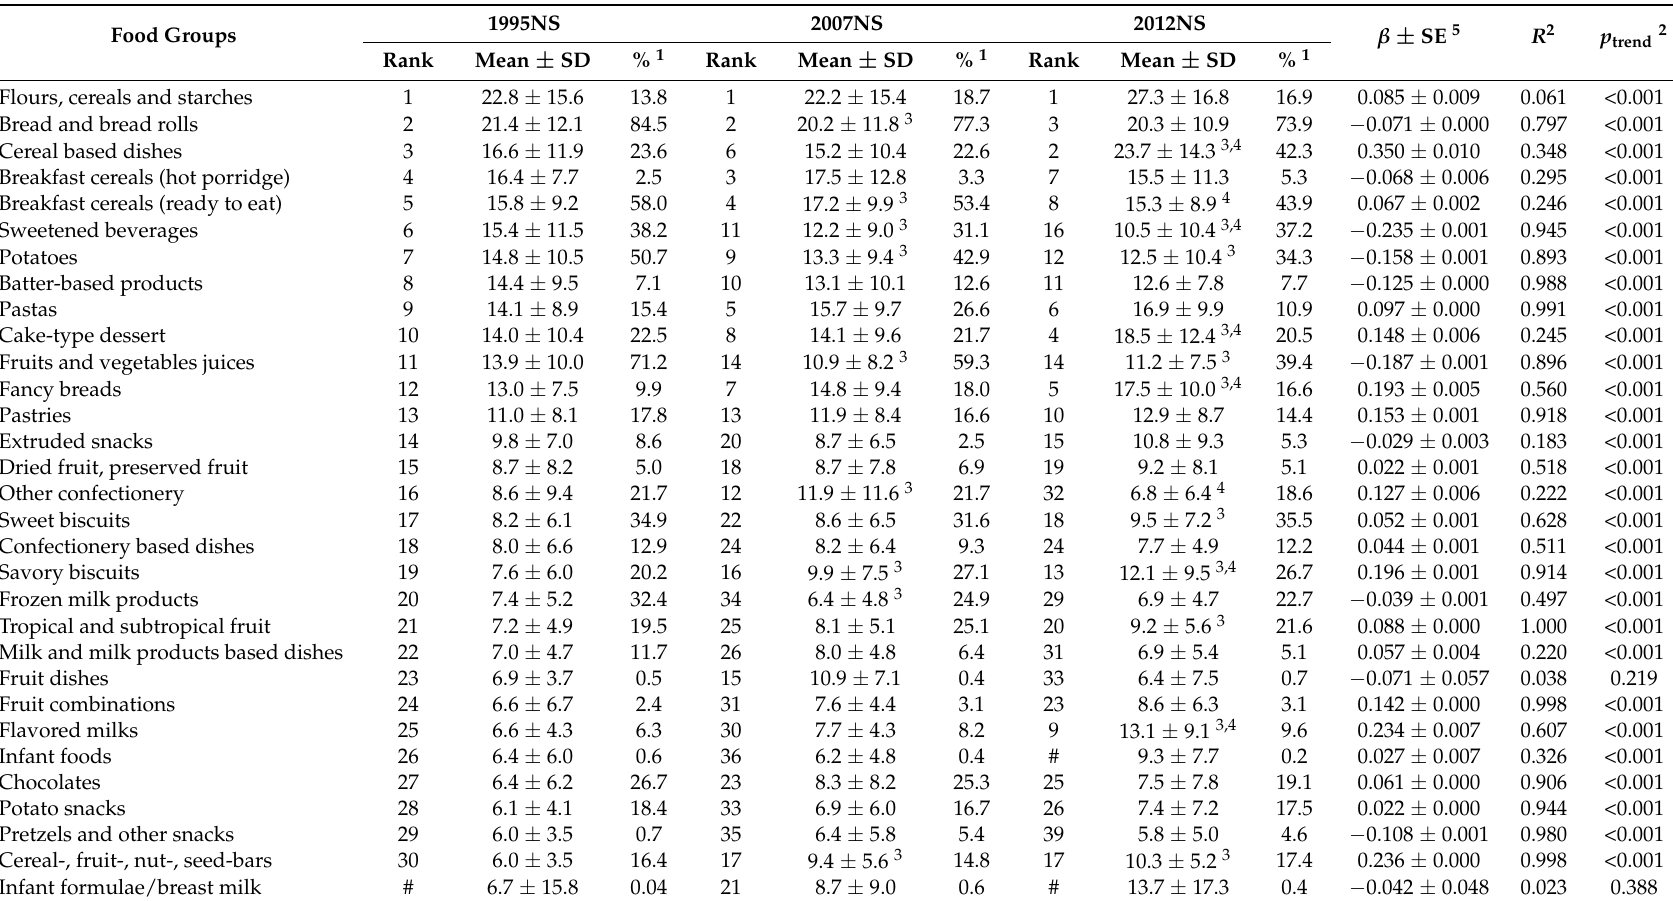
Table 4. Per consumer mean ± SD comparison of the highest contributors to glycemic load in the three